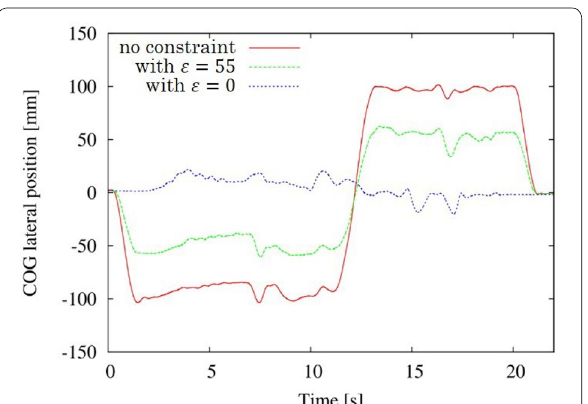
Fig. 20 Change of ξ COG x by longitudinal shift